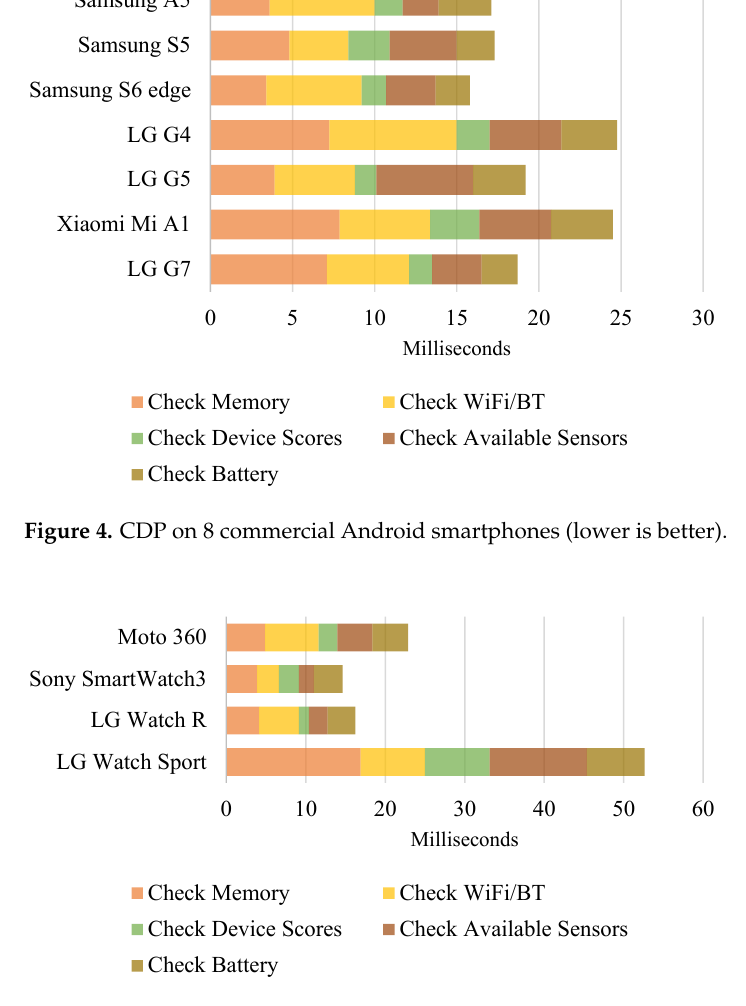
Figure 5. CDP on 4 Wear OS smartwatches (lower is better).